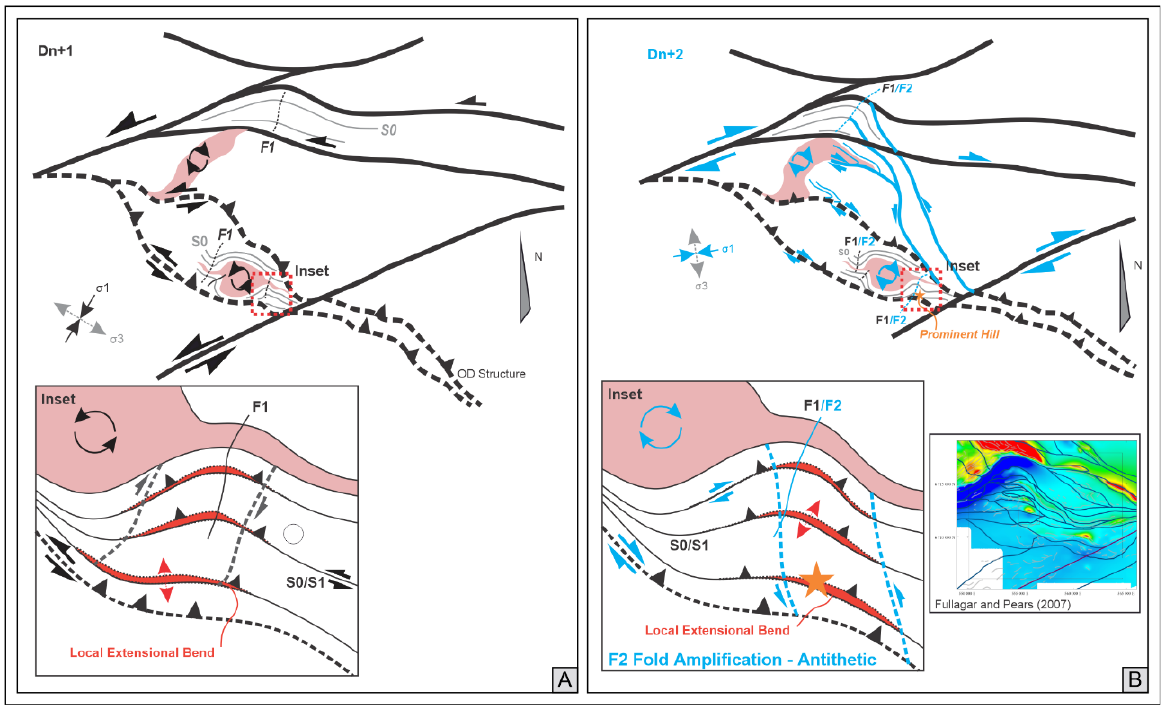
Figure 5. Schematic summary of key structural events, colloquially termed D 1 and D 2 . ( A ) Pre- to Syn-Kimban and Early Kararan Orogeny (~1780–1670 Ma). Key features include left-lateral shearing along the Karari and Bulgunnia Shear/Fault Zones and internal WNW- to E-W-trending synthetic shear zone, development of zones of fabric inflection, anticlockwise rotation of the gabbro/gabbrodiorite body and “stringing” of its tails or terminations into the surrounding fabric and structures. ( B ) Late Kararan and Olarian Orogeny (~1600–1500 Ma, [46])—IOCG mineralisation (1595–1585 Ma, [30]). Key features are a reversal in stresses (E-W compression, N-S extension), intrusion of the Hiltaba Suite throughout the region, the development of an incipient shear zone and dilation of many of the pre- existing structures and fabrics. This dilation was particularly well-developed in the Prominent Hill area, wherein local extensional bends accommodated Fe-rich hydrothermal fluids and mineralisation, expressed by several TMI anomalies in the study of [64], shown as an inset in ( B ). D n+1 , interpreted to coincide with the Kimban Orogeny (1740–1690 Ma) (Figure 5A),